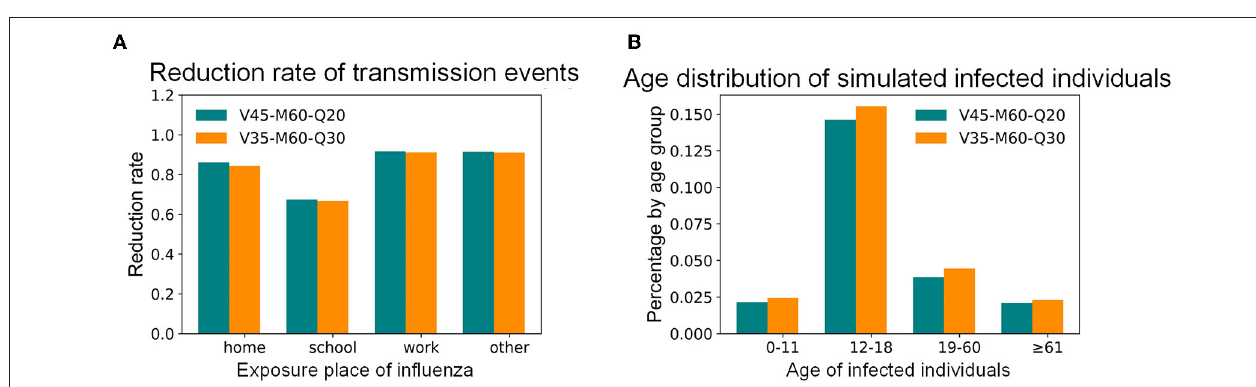
FIGURE 8 | The simulated influenza transmission characteristics in Shenzhen under selected intervention combinations. (A) Distribution of simulated transmission places. (B) Age distribution of simulated infected